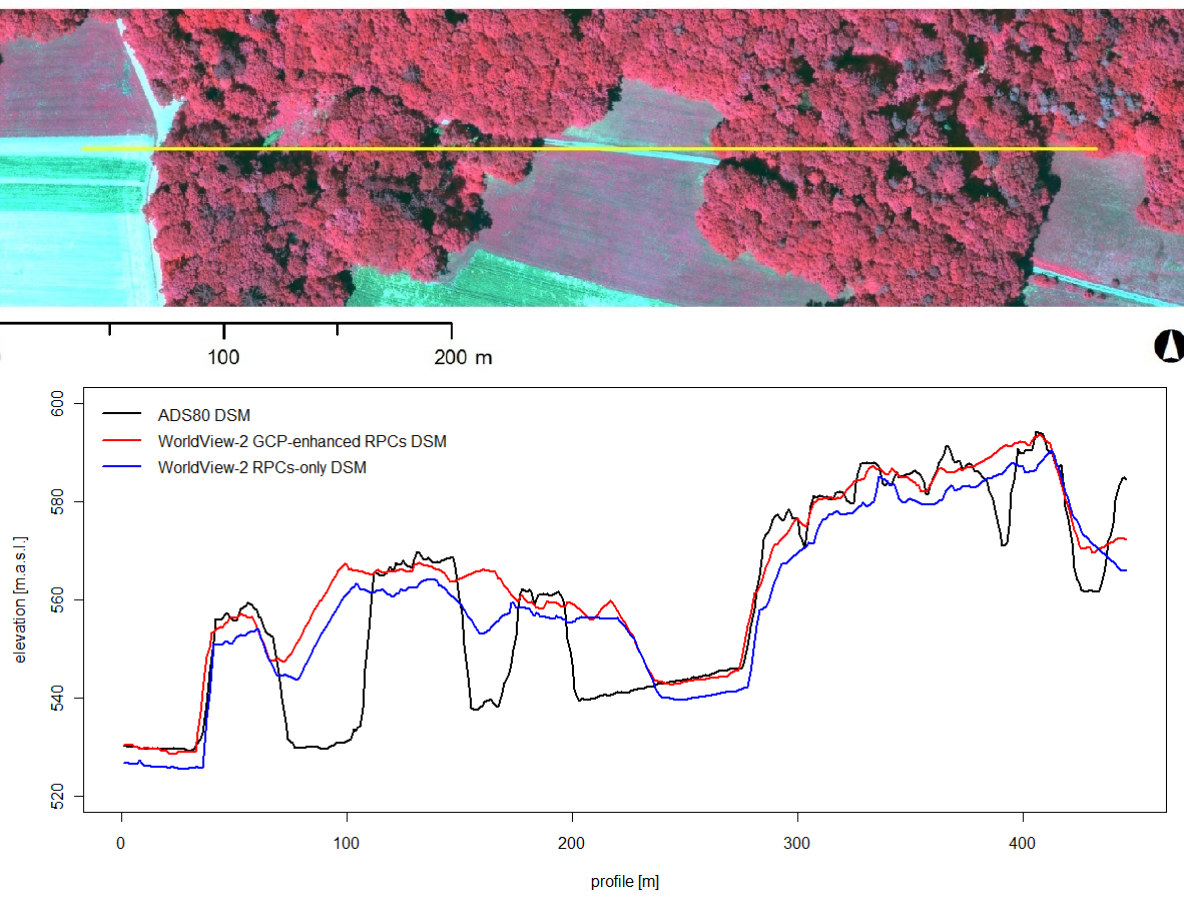
Figure 5. Profile through an exemplary forest stand of the study area to show the difference between the DSM based on airborne (ADS80) and spaceborne (WorldView-2